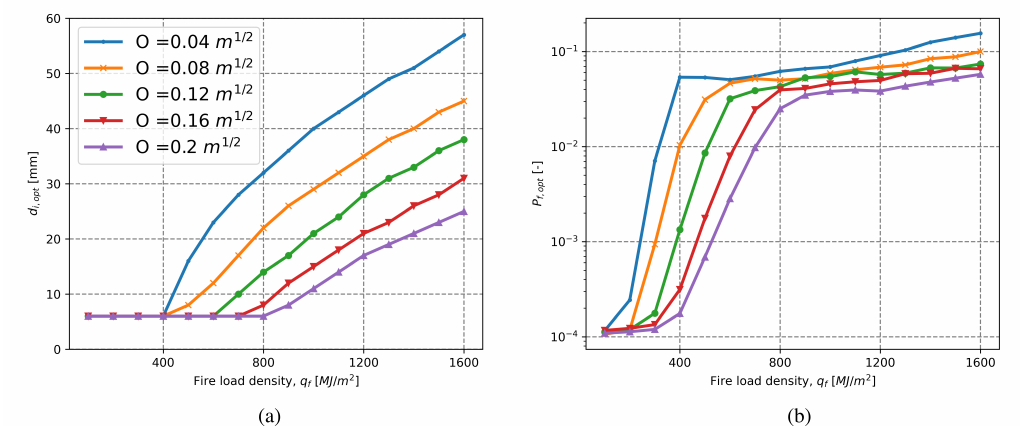
Figure 4. Optimum (a) SFRM thicknesses and (b) failure probability for considered cases of fire scenarios of steel column.